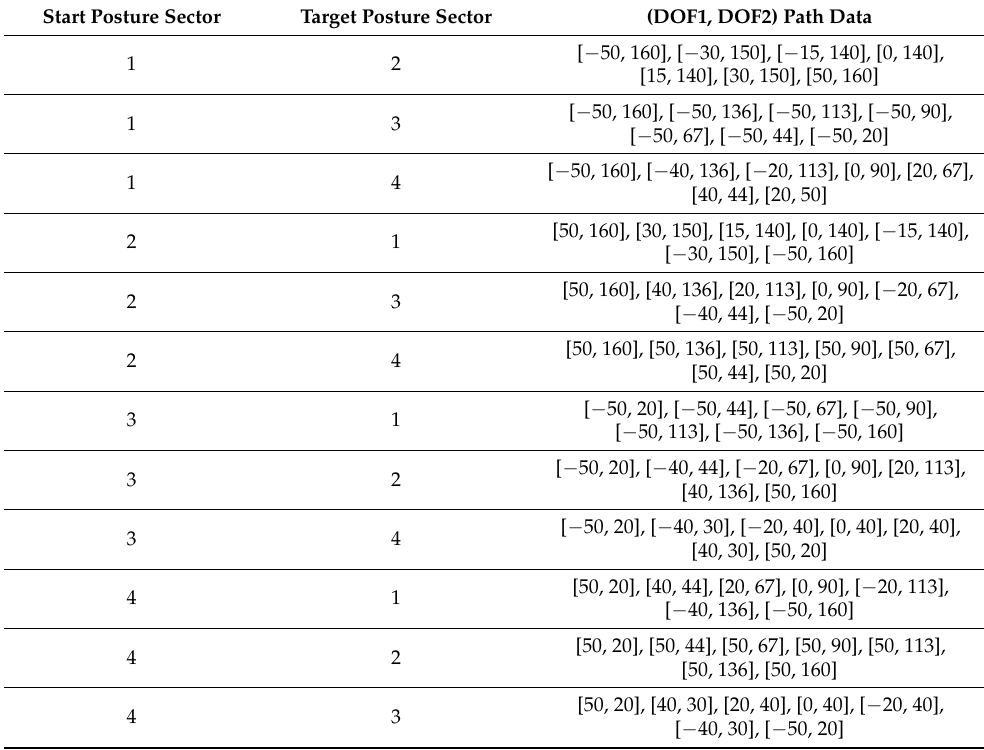
Table 3. DOF1, DOF2 path data between different posture